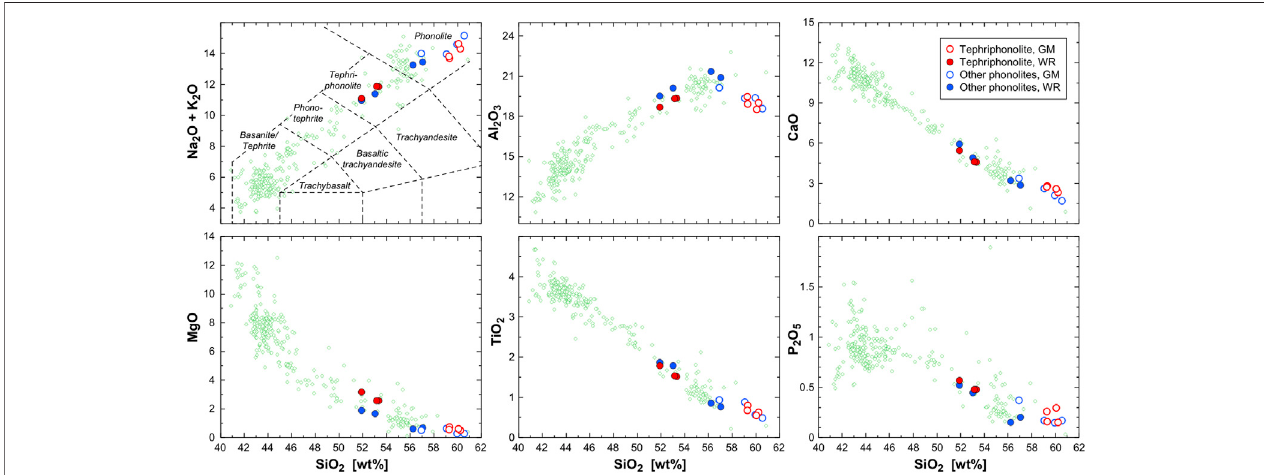
FIGURE 4 | Harker diagrams for samples from the investigated tephriphonolite (red fi lled circles) and its groundmass (red-white circles), from four other tephriphonolitestophonolitesfromCumbreVieja(blue fi lledcircles)andtheirgroundmass(blue-whitecircles),andfromotherhistoricandprehistoricCumbreViejarocks (green diamonds; data from Hernandéz-Pacheco and Valls (1982), Hernandéz-Pacheco and de la Nuez (1983), Elliott (1991), Klügel et al. (2000); Klügel et al. (2017), Carracedo et al. (2001), Johansen et al. (2005), Day et al. (2010), Turner et al. (2015)). Data are normalized to 100% volatile-free. WR, whole-rock; GM, groundmass. The trends in the diagrams are consistent with fractionation of the phenocryst phases observed.